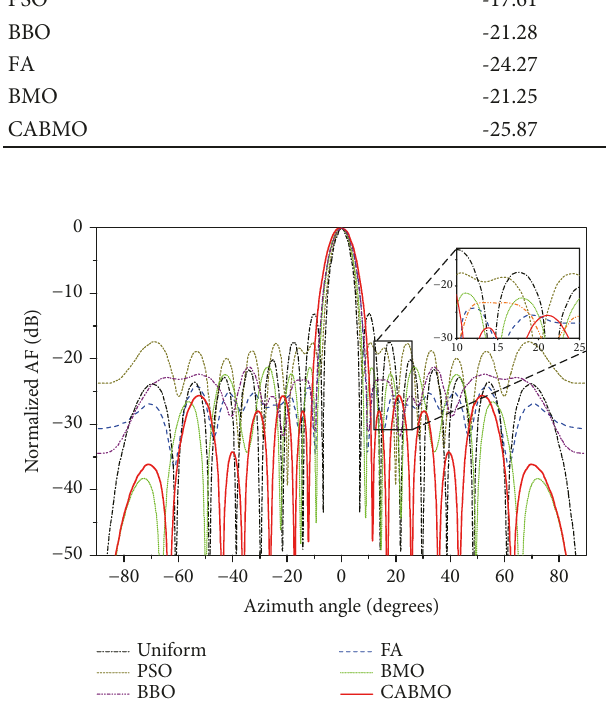
Figure 6: Nominalized AF of the 16-element LAA for case